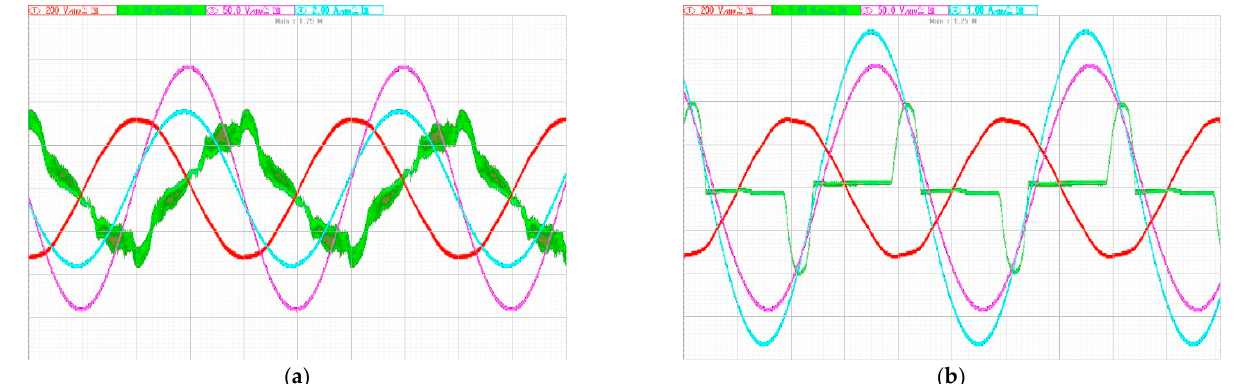
Figure 12. Waveforms of input and output voltages and current of tested. ( a ) PWM-based power source and ( b ) audio power amplifier (yellow—supply voltage, green—supply current, red—output voltage, blue—output current).